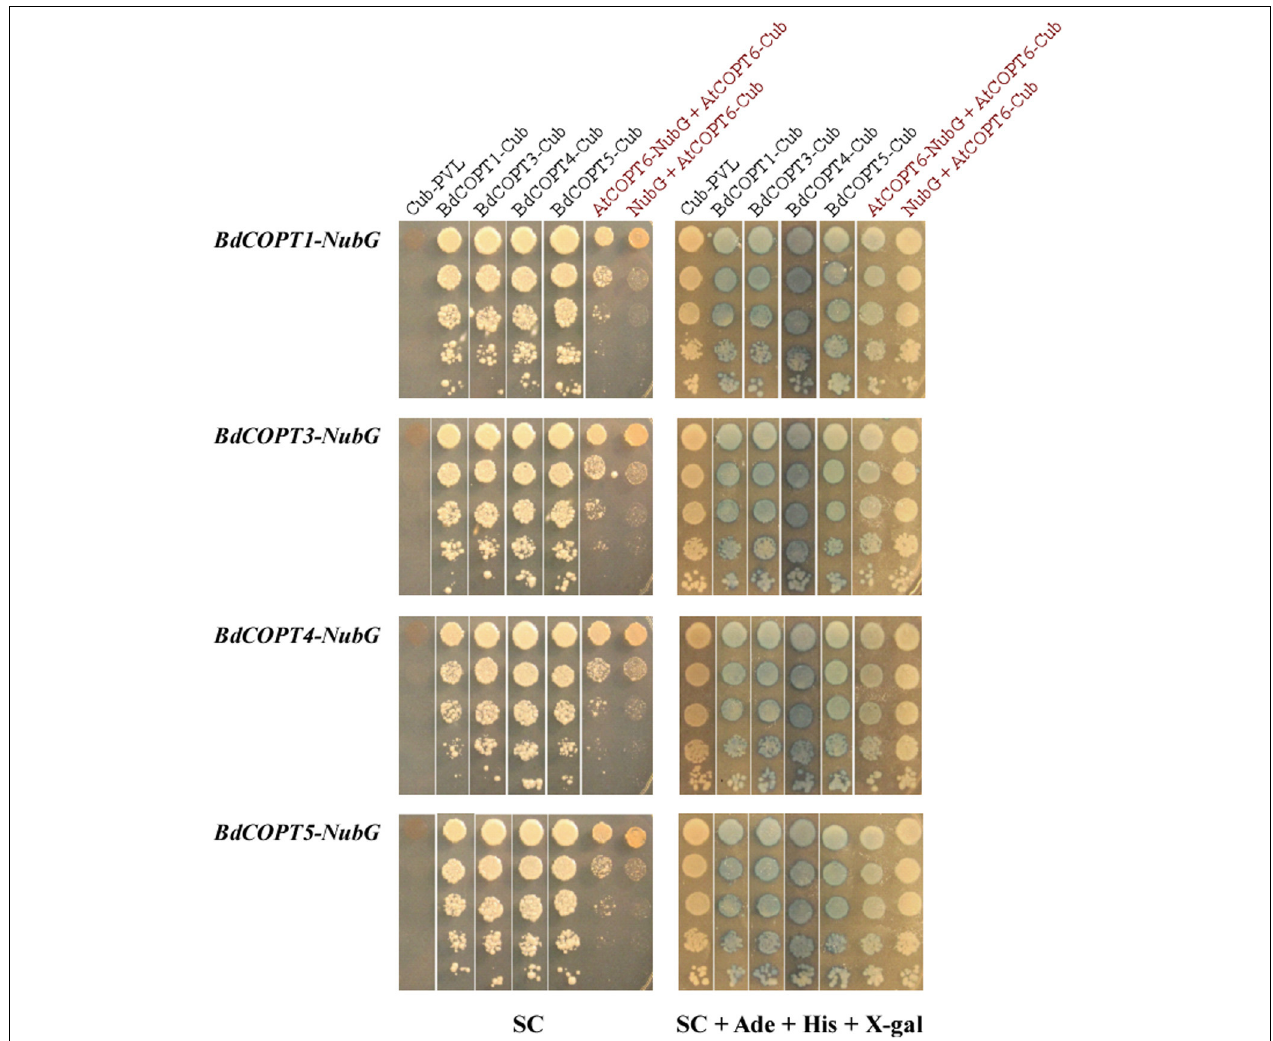
FIGURE 8 | Analyses of protein-protein interactions of brachypodium CTR/COPT transporters using the split-ubiquitin membrane yeast two-hybrid system (MYTH). Shown are yeast cells co-expressing NubG constructs fused with BdCOPT1 , BdCOPT3 , BdCOPT4 , or BdCOPT5 cDNA ( BdCOPT1-, BdCOPT3-, BdCOPT4-, BdCOPT5-NubG ) and a Cub-PLV construct lacking a cDNA insert ( Cub-PLV ) or Cub-PLV fused to BdCOPT1 -, BdCOPT3 -, BdCOPT4 -, BdCOPT5 ( BdCOPT1-, BdCOPT3-, BdCOPT4-, BdCOPT5-Cub ). Interactions were visualized by colony formation on selective